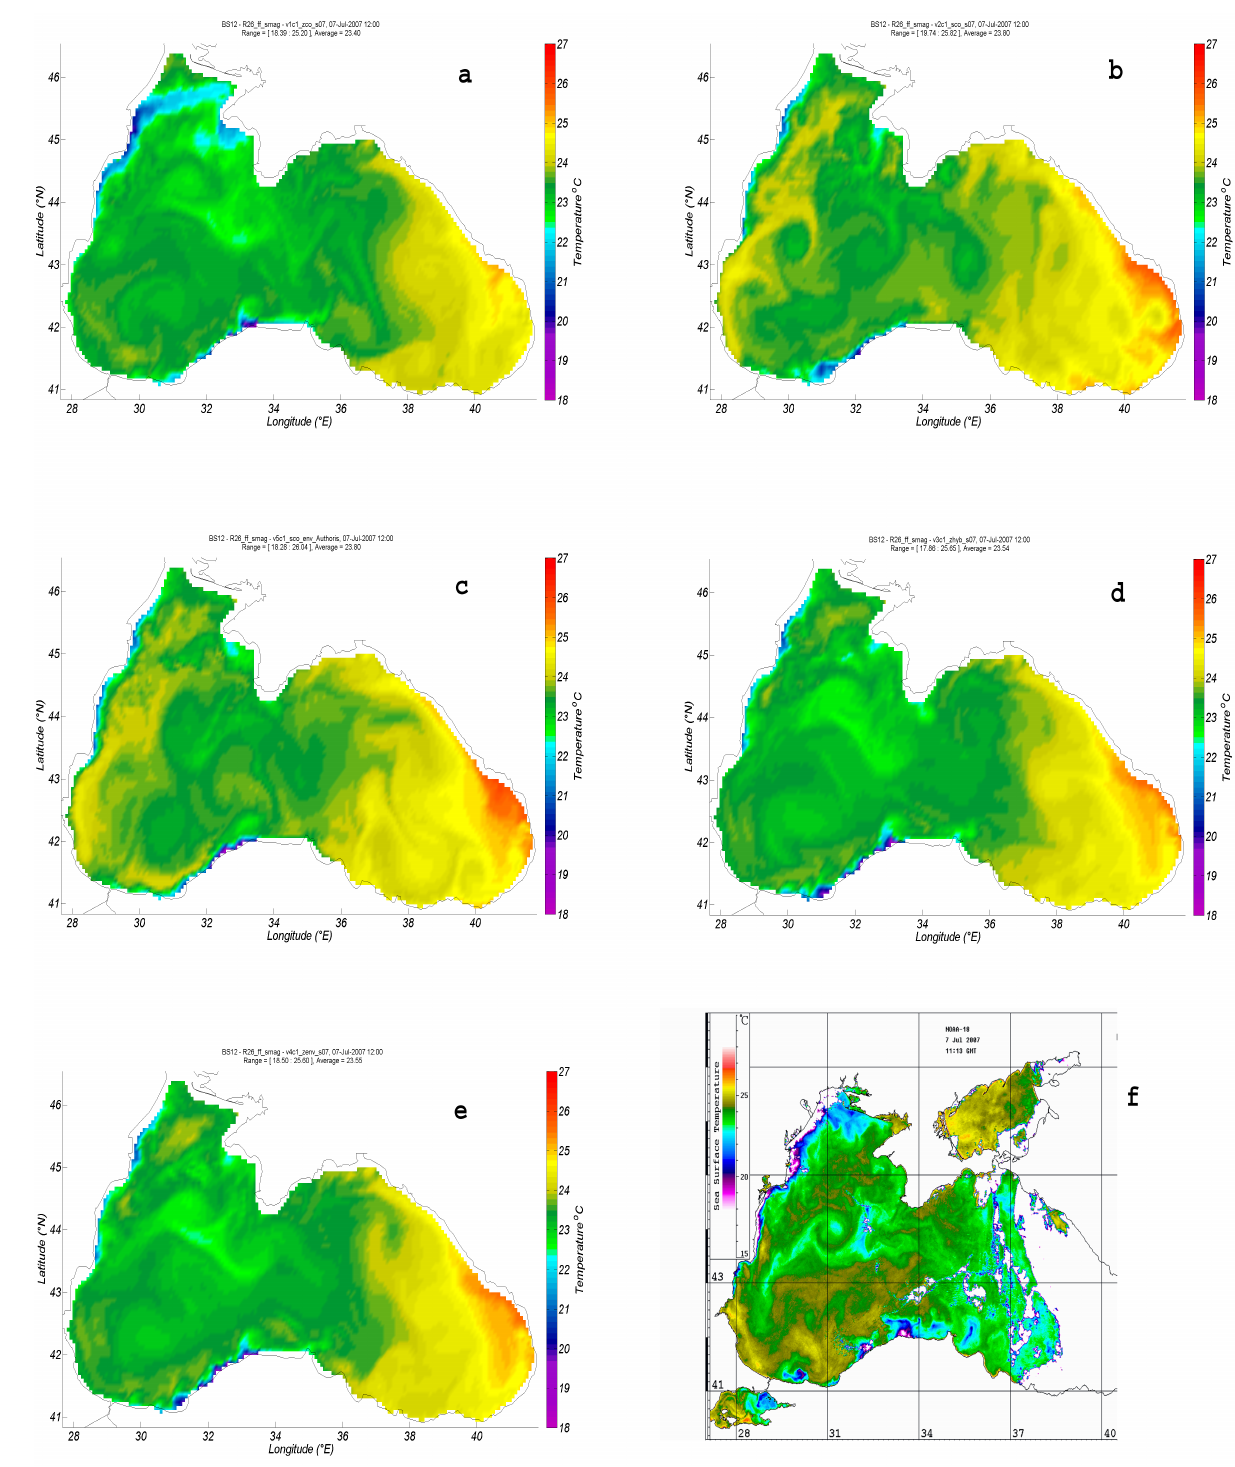
Fig. 8. Sea surface temperature on the 7 July 2007 produced by the model with various grids: (a) ZCO; (b) SCO; (c) Z*SIG; (d) SZH; (e) SZHENV, (f) satellite image from